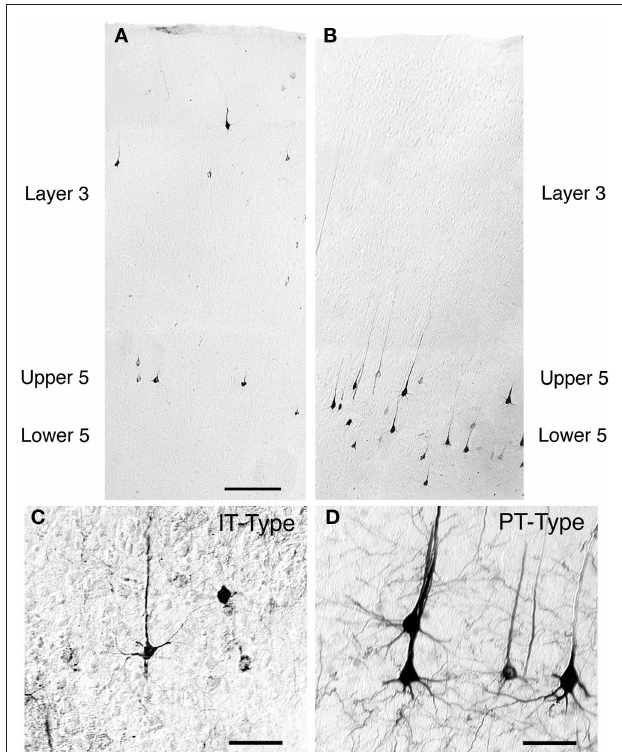
Figure 1 | Low-power images of the laminar distributions in primary somatosensory cortex of intratelencephalically projecting (iT)-type (A) and pyramidal tract (PT)-type (B) perikarya in the same rat. The IT-type perikarya were retrogradely labeled from the contralateral striatum with RDA3k. As is evident in (A) , they are 12–13 μm in size, and largely localized to layer 3 and upper layer 5. By contrast, the PT-type perikarya retrogradely labeled by BDA3k injection into the ipsilateral pontine pyramidal tract are largely localized to deep layer 5 ( B ) and are larger (18–19 μm) than the IT-type perikarya. Scale bar = 200 μm in A (applies to A and B ). Images C and D show high power views of IT-type (C) and PT-type perikarya (D) in cortex. The PT-type perikarya are larger and possess a more prominent apical dendrite than the IT-type perikarya. Scale bars = 50 μm in (C) and (D)